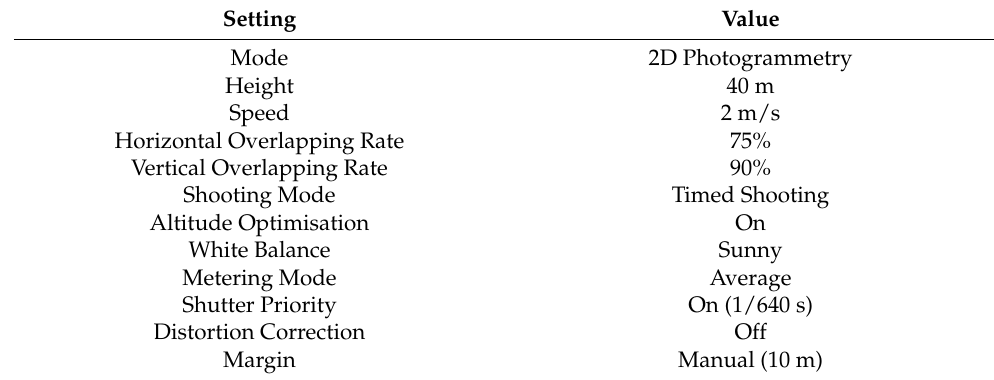
Table 1. Aerial image acquisition settings used during all UAV surveys. Any setting not explicitly mentioned here was kept at default.